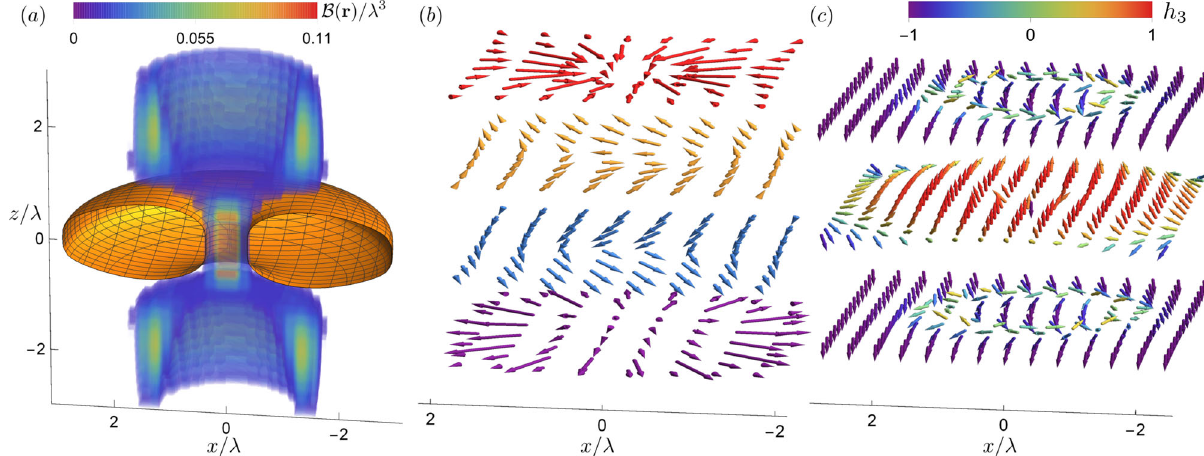
Fig. 2 Topological particle-like objects of optical excitations. a A 3D Skyrmion with the topological charge B = 1, prepared using the light fi eld in Eq. (8) for l = 1; b its arti fi cial gauge vector potential fi eld, represented by the polarisation density current J ; and c the construction of the Hop fi on fi eld pro fi le ^ h . a The con fi nement of the x -polarised electromagnetic vibration of the atoms, P x ( r ), due to the applied level shifts is shown by the isosurface j P x ð r Þj 2 ¼ 0 : 6 D 4 j E ð 0 Þj 2 = ð _ γ Þ 2 (meshed region). The topological charge density B ð r Þ (coloured region) is concentrated at the origin and in two rings where the gradients of the atomic polarisation density become large, with the corresponding J in b exhibiting a fl ow in the ± x directions near the origin or radial fl ow at the charge density rings. In b , c , a geometry of stacked square arrays is chosen for illustrative purposes, although any geometry can be used. All fi gures use the same z -axis. In b , the atomic planes lie at z / λ = ±2.5 and z / λ = ±0.83, and in c lie at z = 0 and z / λ = ±2. The beam widths ( w 0 , w 1 , w 2 )/ λ = (2, 3, 4.5).